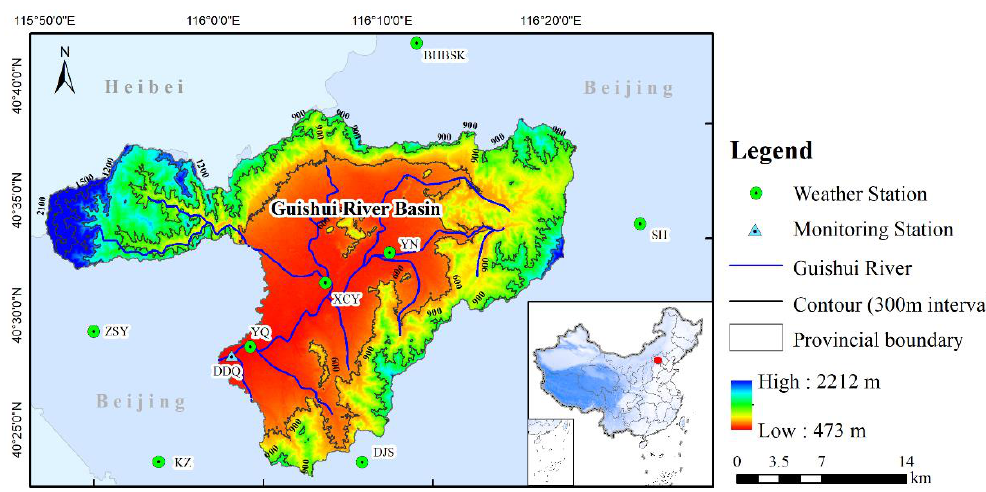
Figure 1. Location of study area.